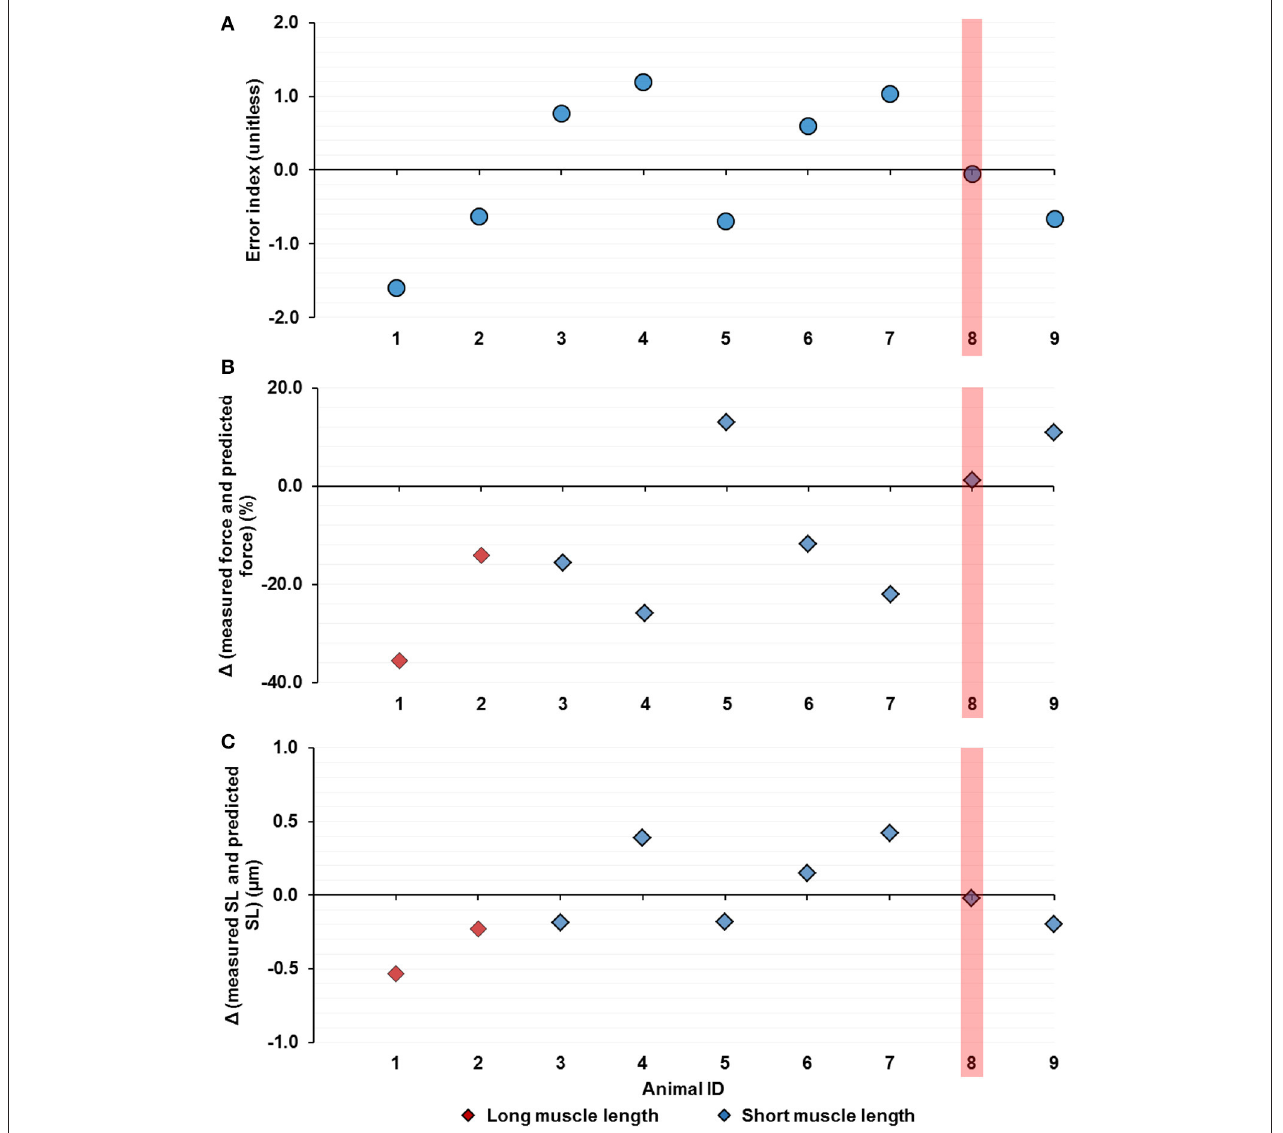
FIGURE 9 | Theoretically predicted forces using the Gaussian-fitted mean sarcomere length (SL) for the individual muscles (N animal = 9) by (A) the error index, (B) the difference between the measured and the predicted muscle force (normalized by the mean isometric force at the short TA length and measured at 200ms, see Figure 8 ) and, (C) the difference between the measured and predicted mean SL (see Methods). The successful prediction, which occurs when the predicted value falls within ± 5% of the measured value, was found only once out of nine times (highlighted in red). The discrepancy between the predicted and measured values can be as big as ∼ 35% of the isometric force of the short TA (B) and ∼ 0.5 µ m in absolute SL (C)